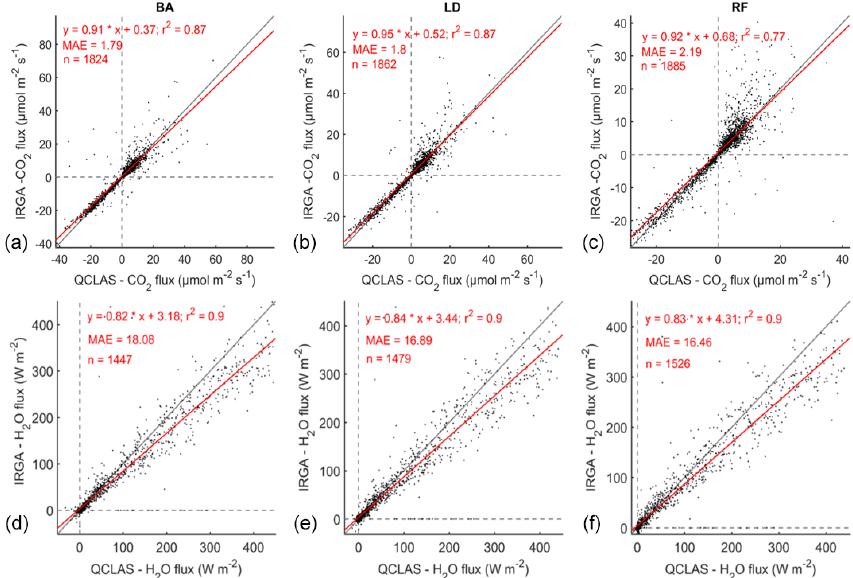
Figure 8. Correlation between IRGA and QCLAS CO 2 (a, b, c) and H 2 O (d, e, f) fluxes using block averaging (BA, a , d ), linear detrending (LD, b , e ) and a recursive filter with a 50s time constant (RF, c , f ). The solid grey line indicates the 1:1 line and the solid red line is the geometric mean regression fit. The regression coefficients, the coefficient of determination ( r 2 ) , the mean absolute error (MAE) and the number of samples ( n ) are indicated in each